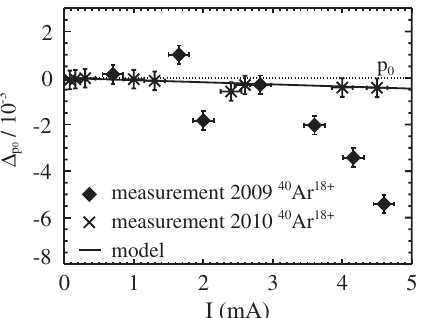
FIG. 12. Comparison of measured energy loss in the SIS with the model of parasitic coherent energy loss as a function of intensity. Shown are the 2009 measurement results (diamonds) and the 2010 results (crosses) together with an analytic